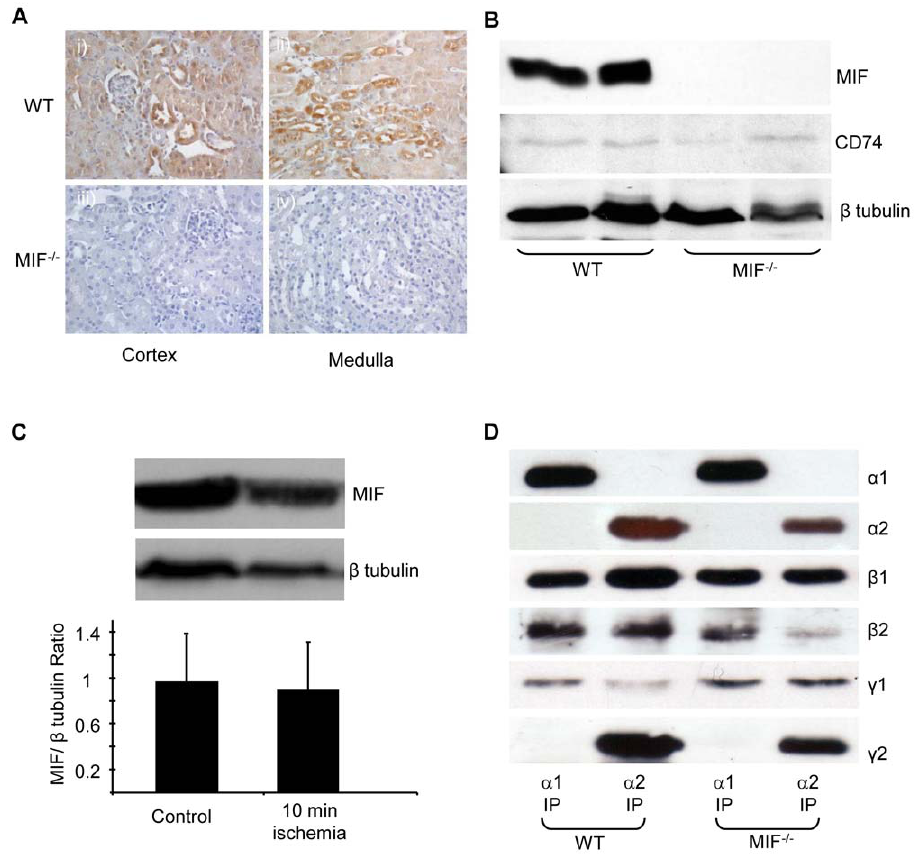
Figure 5. MIF and AMPK expression in MIF and WT mice. A. Renal expression of MIF was determined by immunohistochemical staining using a monoclonal Ab against MIF (ab 7207) in sections from cortex and medulla. To ensure the specificity of staining, immunohistochemistry was performed on sections from WT (C57Bl/6) and MIF 2 / 2 kidneys. B. Kidney lysates from MIF 2 / 2 and WT mice were analyzed by Western blot with a mouse monoclonal against MIF. MIF was detected as a single band at 14 kDa. There was no difference in CD74 expression between WT and MIF 2 / 2 mice. Western blotting for b -tubulin was performed to confirm equivalent protein loading. C. MIF expression was analyzed by Western blot from lysates of control and ischemic (10 mins) kidneys of WT mice. MIF expression was quantified by densitometry of western blot blots control and ischemic kidneys. n=7 for both groups. MIF expression was normalized to b -tubulin expression to ensure even loading. Results shown as mean 6 SD. D. Immunoprecipitations were performed from kidney lysates (4 mg protein) of MIF 2 / 2 and WT C57Bl/6 mice with rabbit polyclonal antibodies against the a 1 and a 2 catalytic subunits of AMPK. The immunoprecipitated complexes were separated by SDS-PAGE and western blotted with antibodies against a 1, a 2, b 1, b 2, c 1 and c 2 subunits of AMPK. Blots shown are representative of 3 individually performed